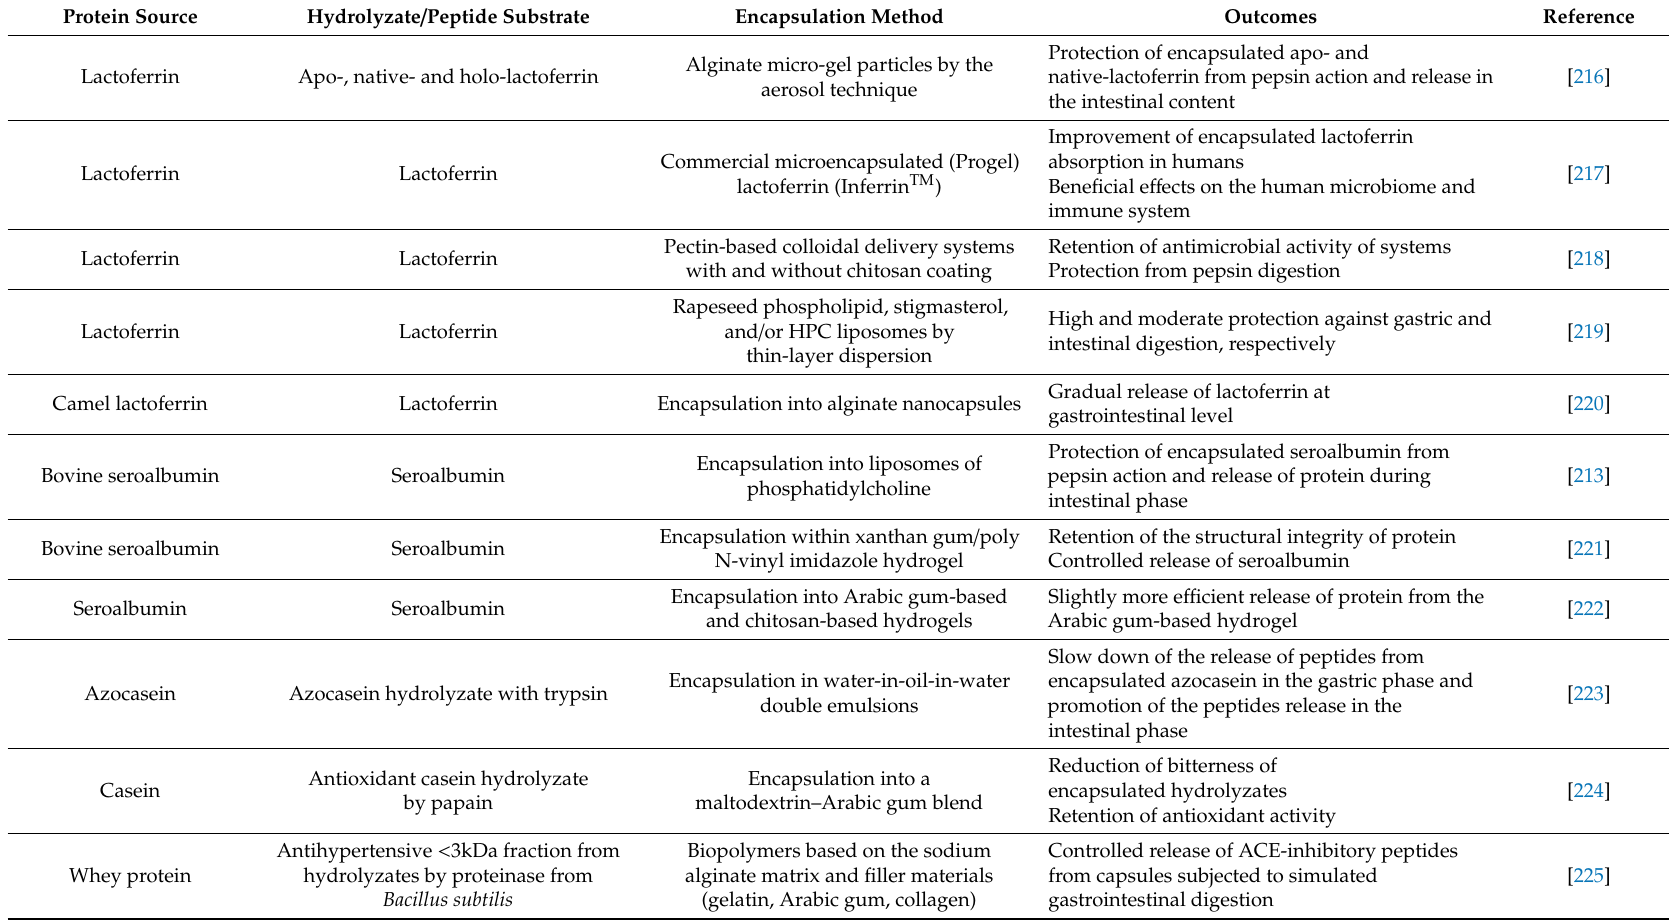
Table 3. Recent encapsulation systems developed for the delivery of food bioactive proteins /